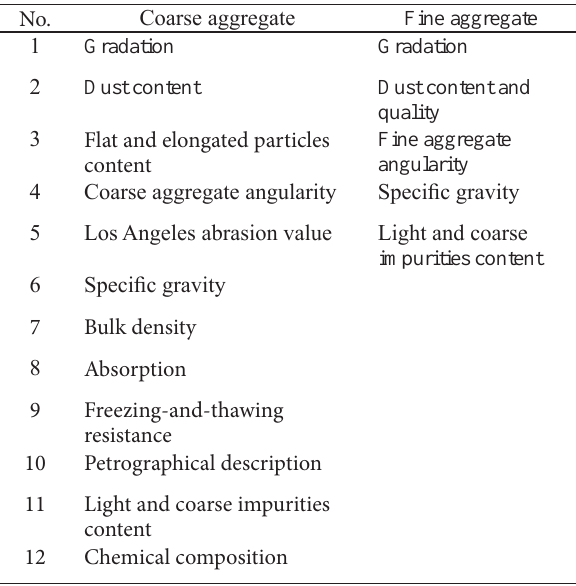
Table 1. List of tests conducted for the aggregate from the glacier formation No.